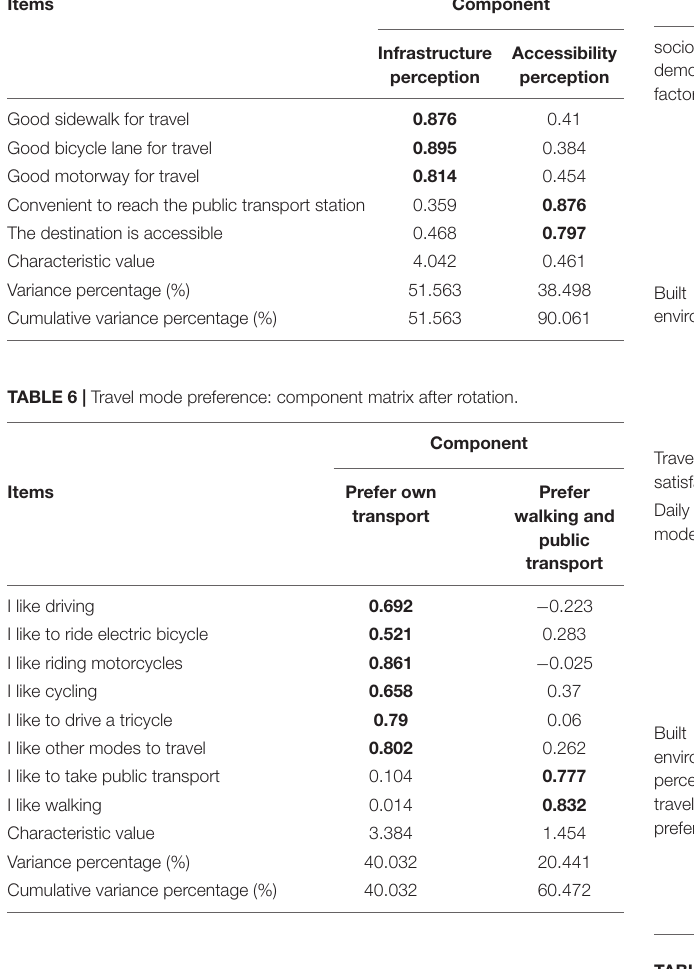
TABLE 8 | Fitting results of